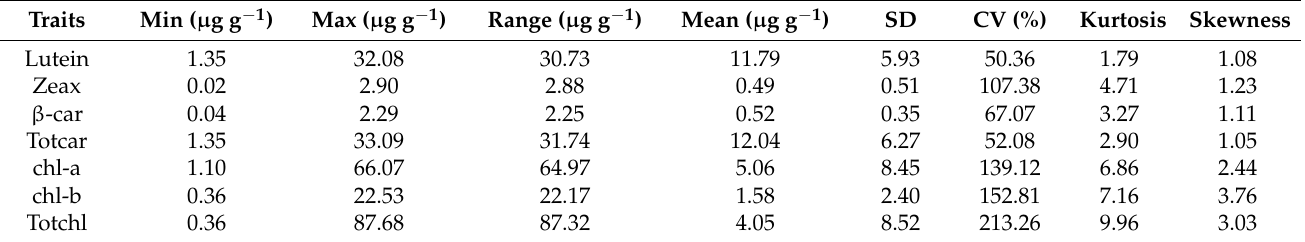
Table 1. Descriptive statistics for the concentrations of carotenoid and chlorophyll traits in soybean accessions grown in two locations for two